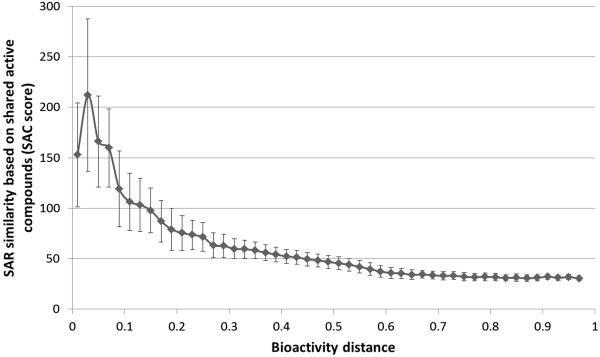
Average trend of SAR similarity based on shared active compounds for all kinases (181) showing the expected negative relationship between SAR similarity and bioactivity distance (excluding kinases from outlier group 1). Error bars indicate 1 standard deviation. The number of shared active compounds was normalized by the total number of active compounds in the variable kinase. Interestingly, the optimum in SAR similarity for kinases is not at the lowest distances: kinases show a lower degree of SAR similarity at distances smaller than 0.03 than the optimum which is at a distance of approximately 0.03. Furthermore, variance in shared active compounds decreases with increasing bioactivity distance (after distance is approximately 0.03), suggesting that it is easier to predict SAR similarity for distant kinases than for closely related kinases.